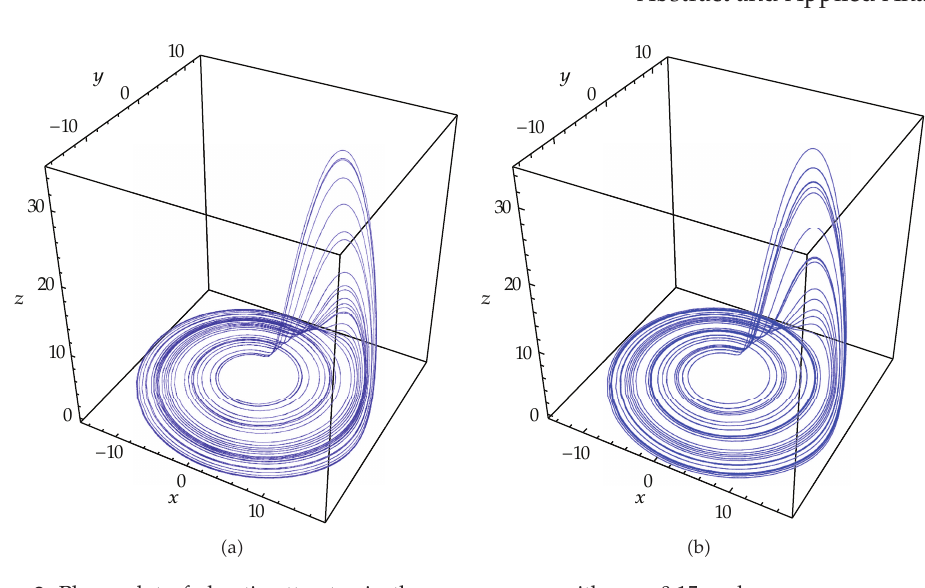
Figure 2: Phase plot of chaotic attractor in the x - y - z space, with a (cid:8) 0 . 15 and α 1 (cid:8) α 2 (cid:8) α 3 (cid:8) 1: (cid:3) a (cid:4) MSGDTM, (cid:3) b (cid:4) RK4.